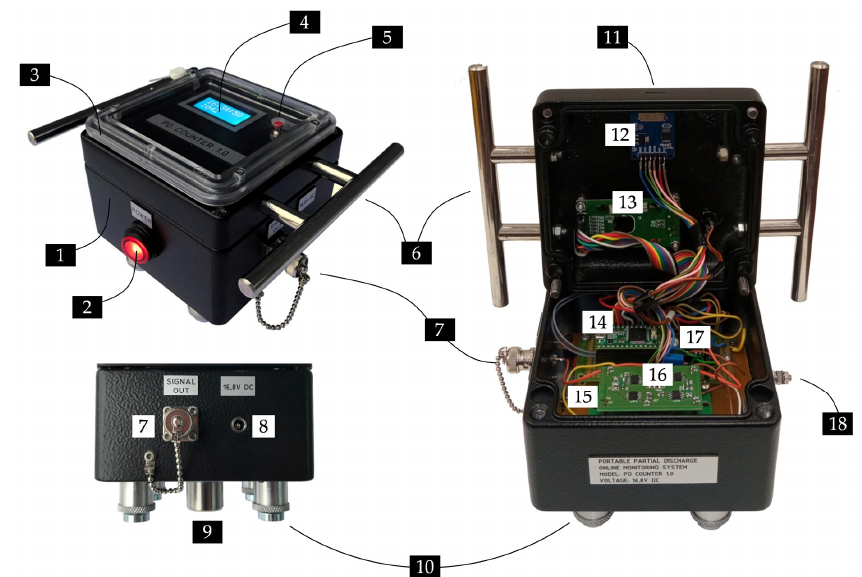
Figure 8. Photo of the system assembly: 1—aluminum electronic enclosure, 2—power switch, 3— polycarbonate inspection window, 4—LCD display, 5—reset switch, 6—handles, 7—BNC connector (bandpass filter output) for optional AE signal transmission, 8—DC power connector, 9—piezoelec- tric transducer, 10—magnetic holders, 11—micro SD card slot, 12—memory card adapter, 13—LCD